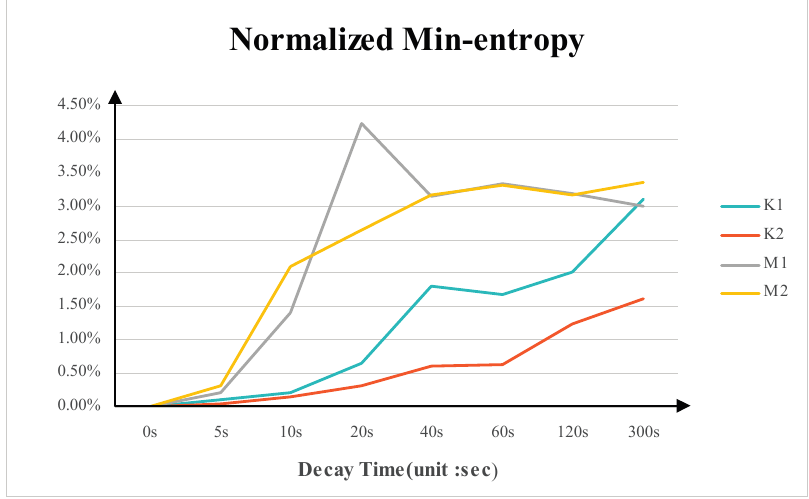
Figure 9. The normalized min-entropy for the tested DDR3 memories at different power-switch